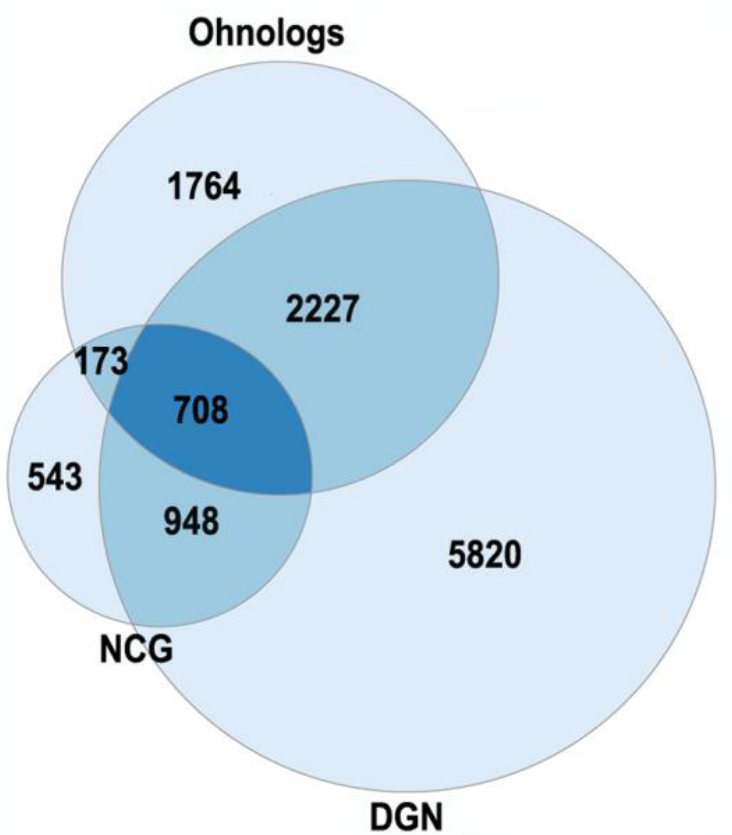
Figure 3. The enrichment of human ohnologs in Network of Cancer Genes (NCG) and Disease Gene Network (DGN). NCG: p < 10 − 46 , DGN: p < 10 − 107 . The NCG were from [54], the DGN (curated part) were from [55].